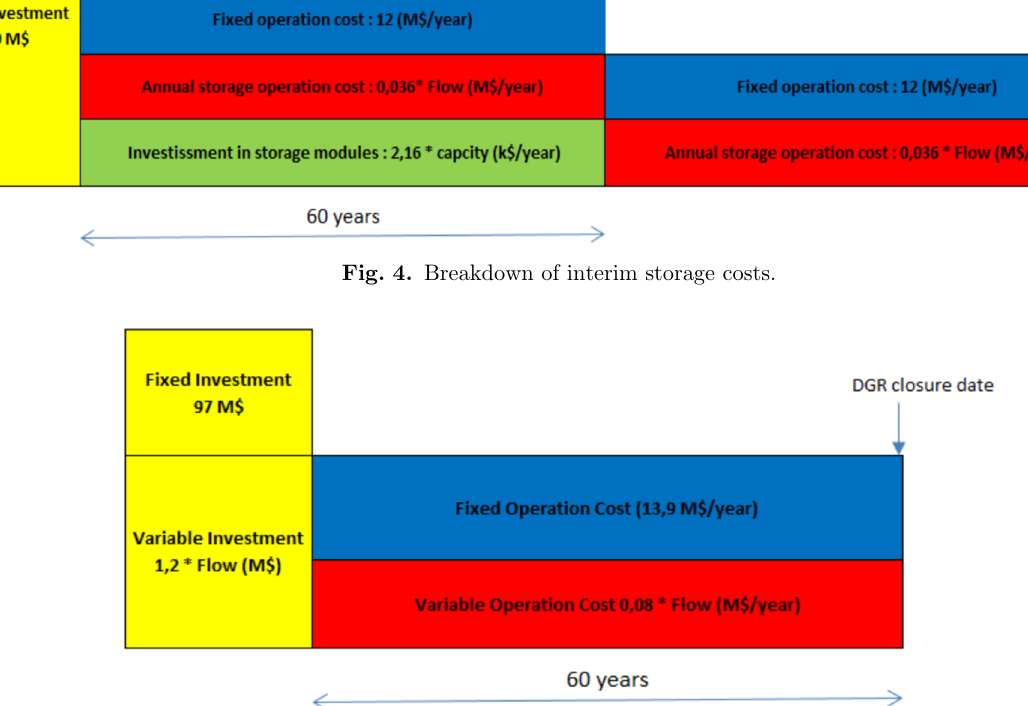
Fig. 5. Breakdown of encapsulation costs.